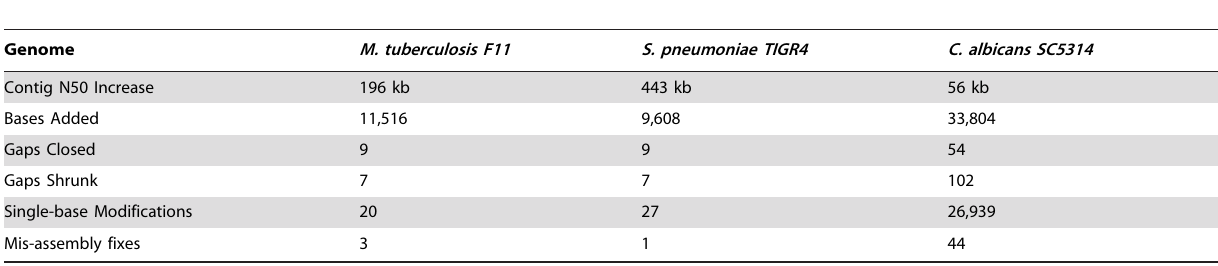
Table 1. Summary assembly statistics before and after Pilon